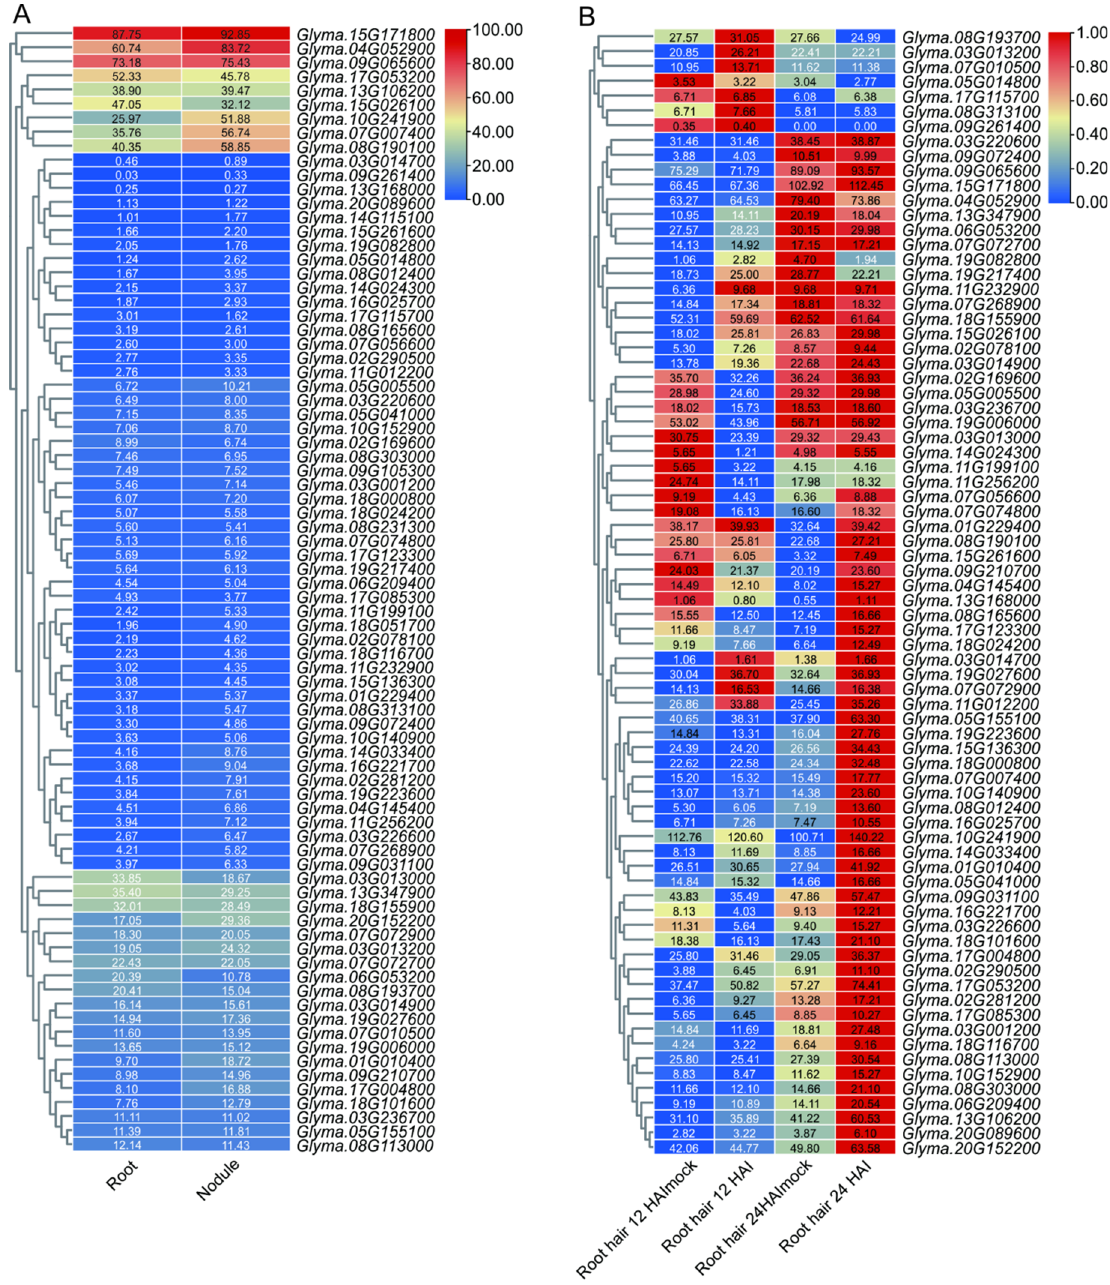
Figure 5. Expression analysis of DDX genes in the root and nodule, and their response to rhizobium. A heat map with clustering was created based on the RPKM value of 80 DDX genes of soybean. ( A ) Expression patterns of DDX genes in the root and nodule. ( B ) Expression patterns of DDX genes’ response to rhizobium in root hair at 12 and 24 h after inoculation (HAI). The colored scale varies from green to red, which indicates low or high levels of gene expression. Root hair 12 HAImock/Root hair 24 HAImock and Root hair 12 HAI/Root hair 24 HAI indicate root hairs at 12 h/24 h after inoculation without and with rhizobia, respectively.